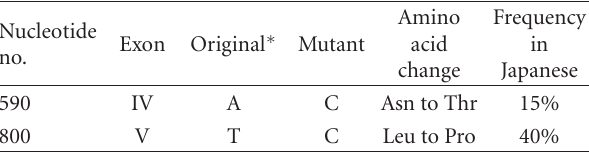
Table 1: Frequency of SNPs in BTLA gene in healthy Japanese